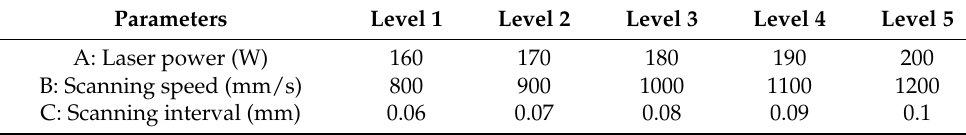
Table 2. The process parameters and their levers used in this